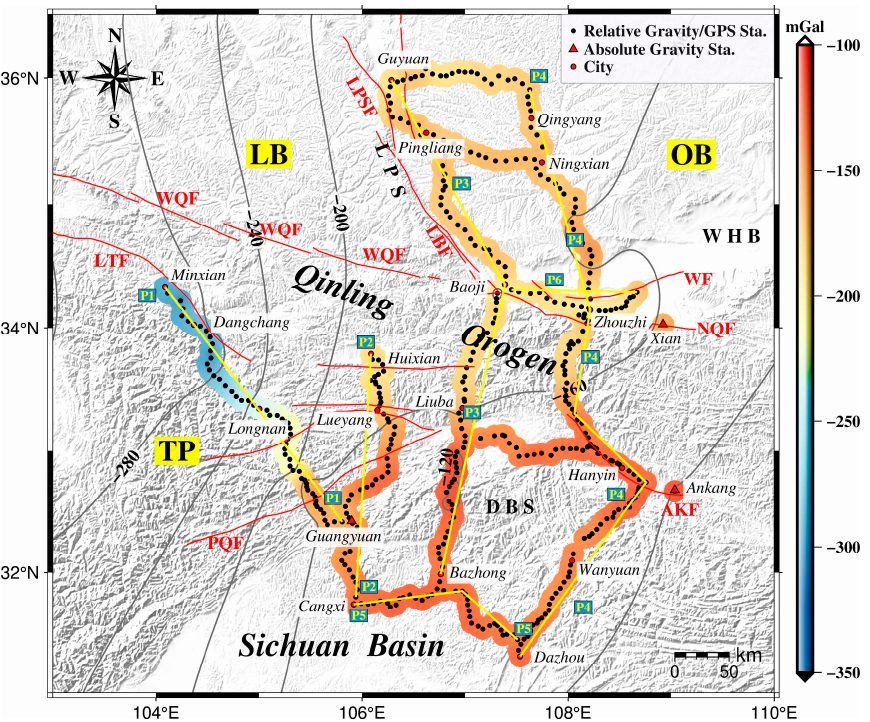
Figure 3. Bouguer gravity anomaly map in the Qinling area. Abbreviations are the same as those used in Figure 1.